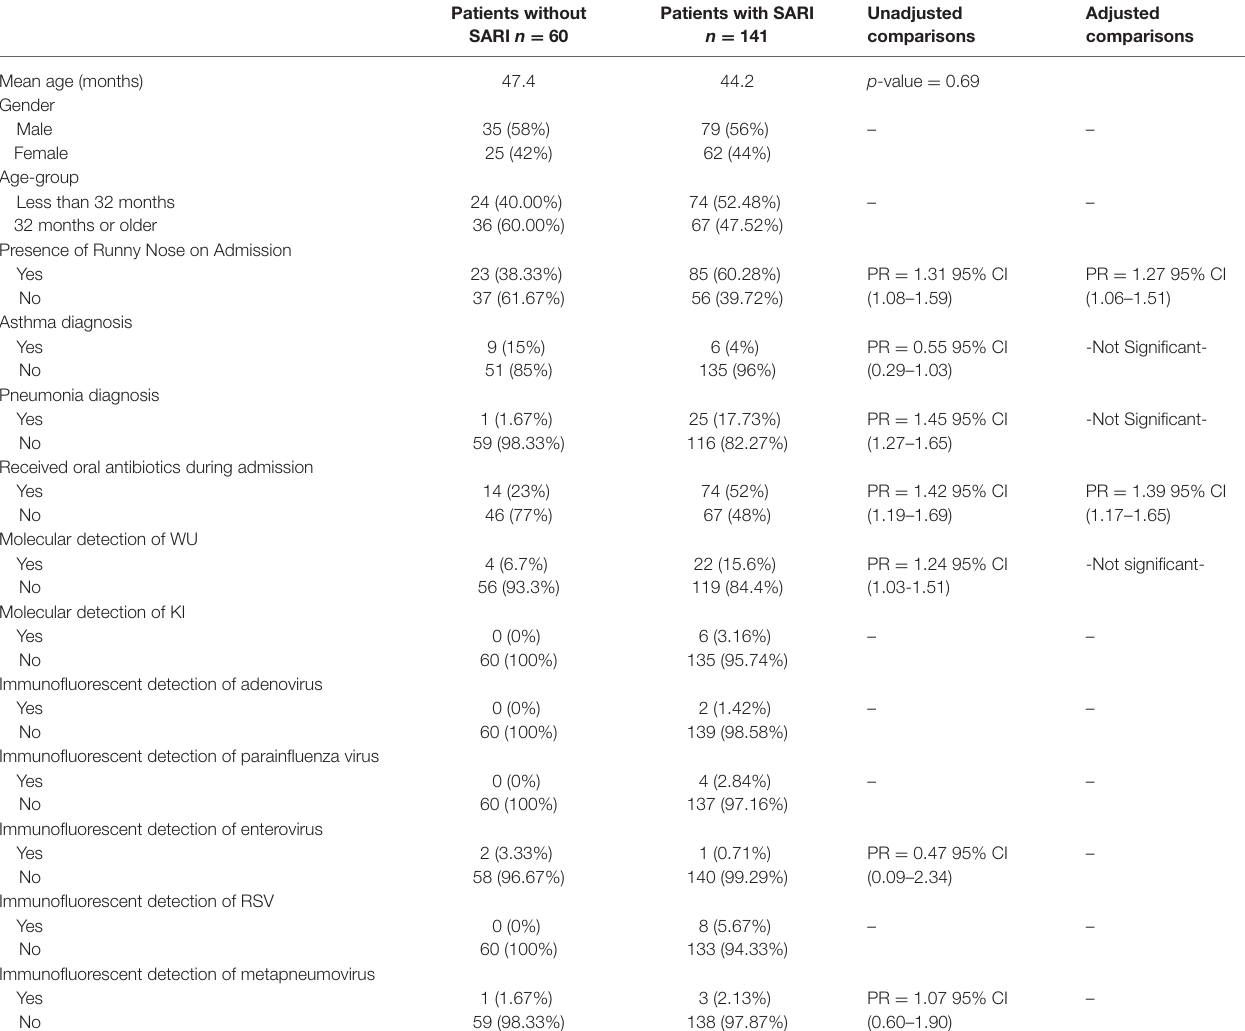
TABLE 1 | Characteristics of 201 pediatric study subjects and an examination of their risk factors for severe acute respiratory infection (SARI), Singapore December 2016 to April